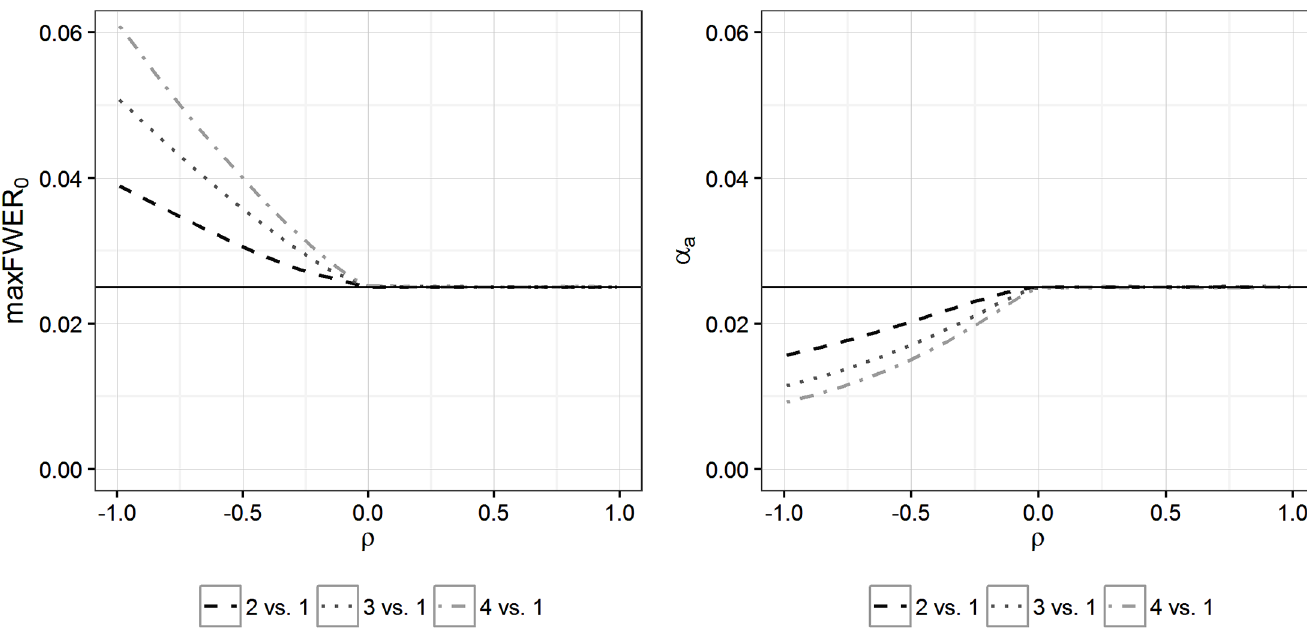
Fig 1. Maximum FWER o (left) and corresponding adjusted nominal levels (right). In the left figure, worst case FWER o for varyingcorrelations ρ betweentoxicity and efficacy are drawn for the ZT for 2, 3, and 4 treatments. The maximum FWER o is constant for values of ρ (cid:21) 0 and increasesfor decreasing ρ < 0. At ρ = − 1 the maximum worst case FWER o is reached. In the right figure, the correspondingadjustednominallevels α a to be used in a ZT correcting for the number of selectedtreatments are presented as a function of the true group correlations ρ (as describedin Section 5.1). Positive correlation implies FWER o control, in which case α a = α nom . In case of negativecorrelationthe FWER in the efficacy testing step has to be controlledat a specific level α a < α nom to ensurecontrol of the worst case FWER o at level α nom .